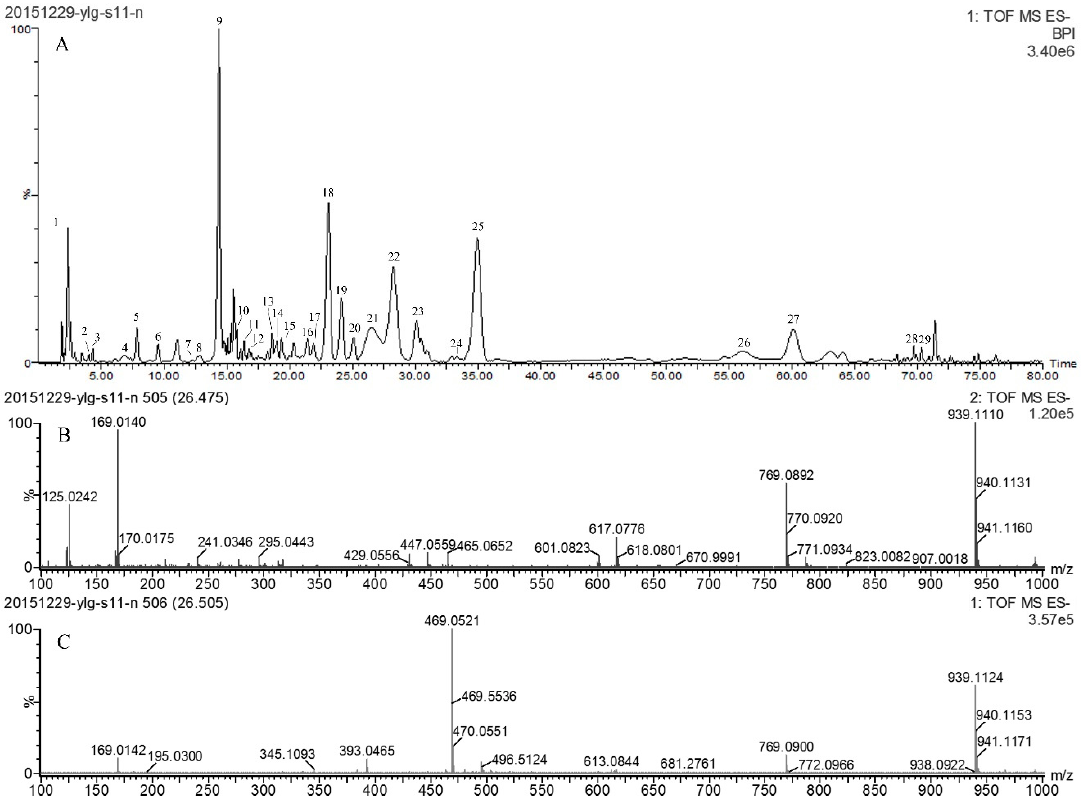
Figure 3. UPLC-QTOF-MS/MS data of the ATL extract obtained under the optimized conditions. Besides the UPLC-MS profile ( A ), a peak with the retention time at 26.51 min was identified as pentagalloyl glucose based on its MS ( B ) and MS/MS ( C ) fragments.